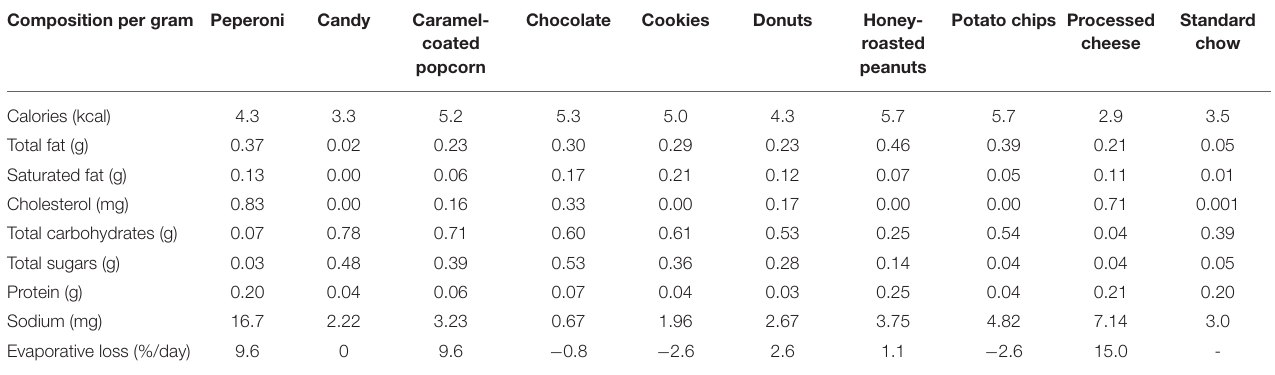
Chocolate Cookies Donuts Honey- coated popcorn